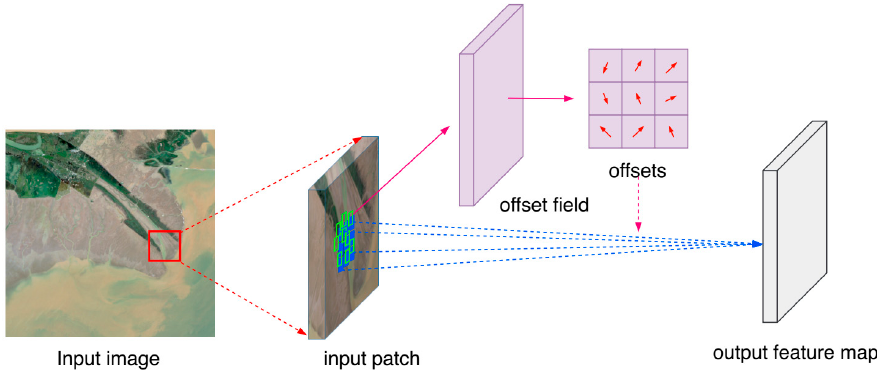
Figure 6. Illustration of a 3 × 3 deformable convolution.